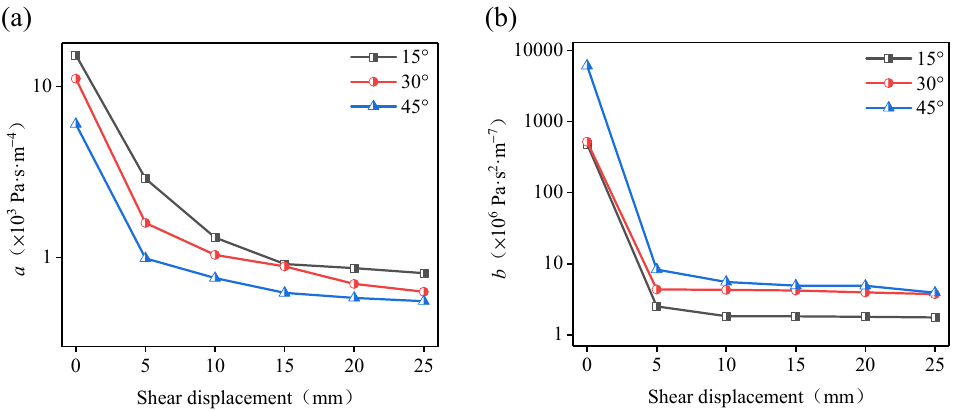
Figure 6. Variation of the coefficients in the Forchheimer equation as a function of shear displacement, including ( a ) a and ( b ) b .